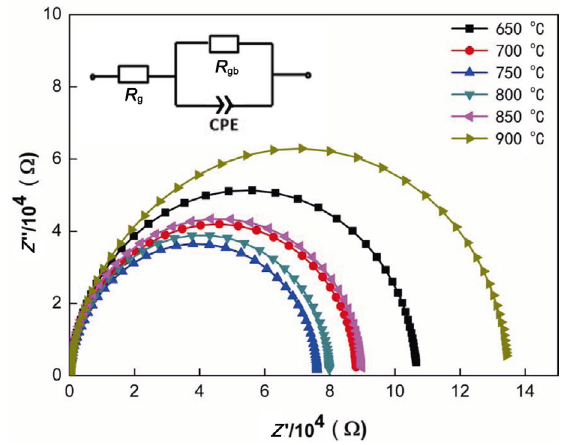
Fig. 11 Complex impedance spectroscopy of MCNO thin films with different annealing temperatures.